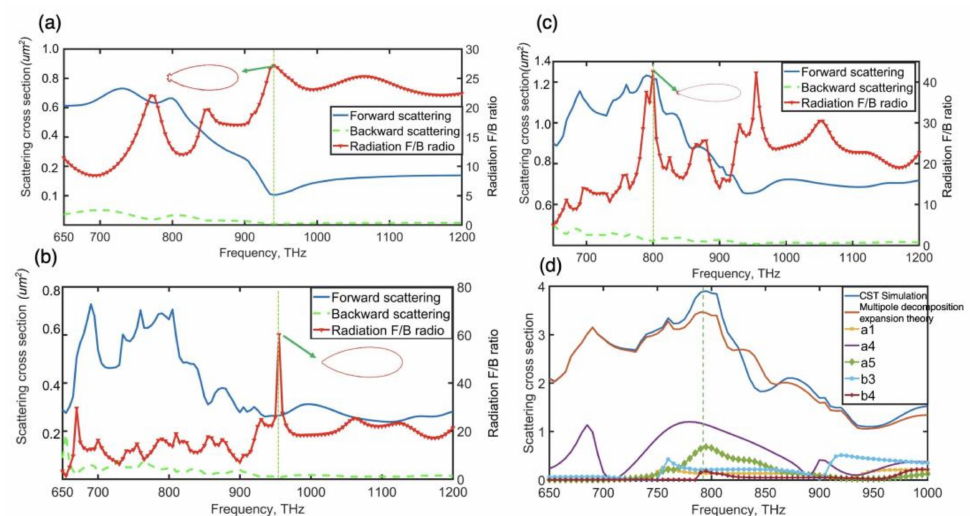
Figure 2. CST simulation structures and results. ( a – c ) The scattering field and forward to backward ratio of the large nanosphere ( a ), the small nanosphere ( b ), and the dimer with 40 nm gap ( c ) and theoretical study of coupling situation of scattering spectra is compared to CST simulation results ( d ) and insets displaying radiation pattern diagrams at the specific